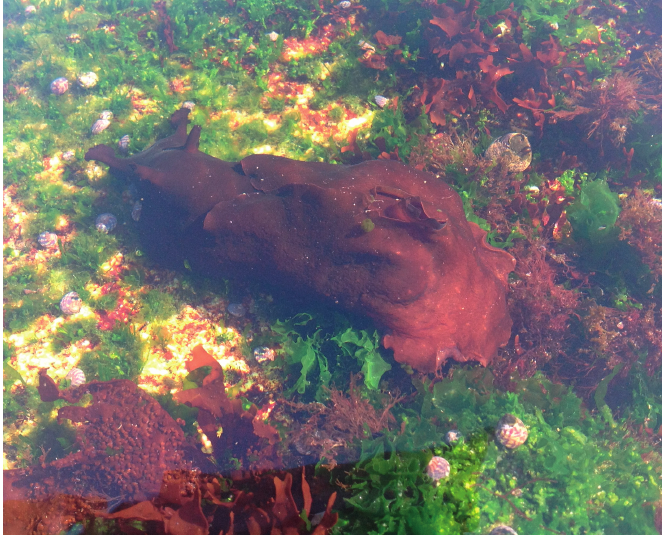
Figure 1. Aplysia depilans